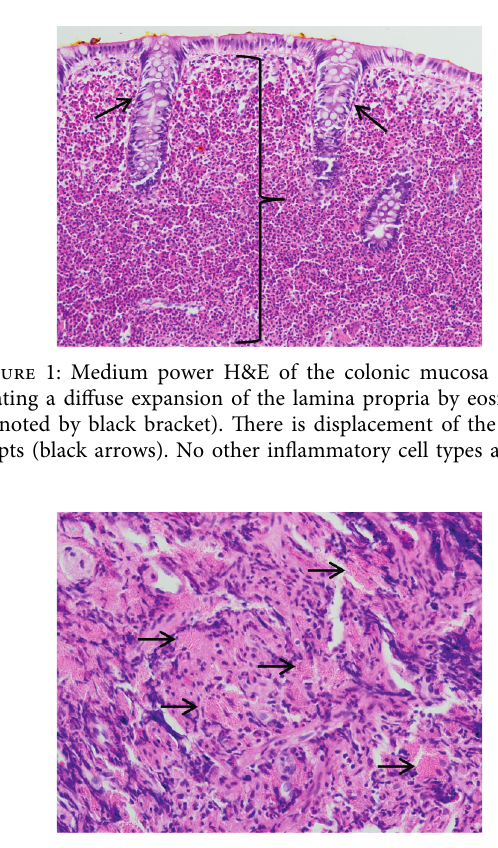
Figure 2: High power H&E showing aggregates of histiocytes within the muscularis mucosa and superficial submucosa. The cytoplasm of the histiocytes contains eosinophilic Charcot–Leyden crystals which are present in the form of fine, granular, and needle- shaped deposits within the macrophage cytoplasm (black